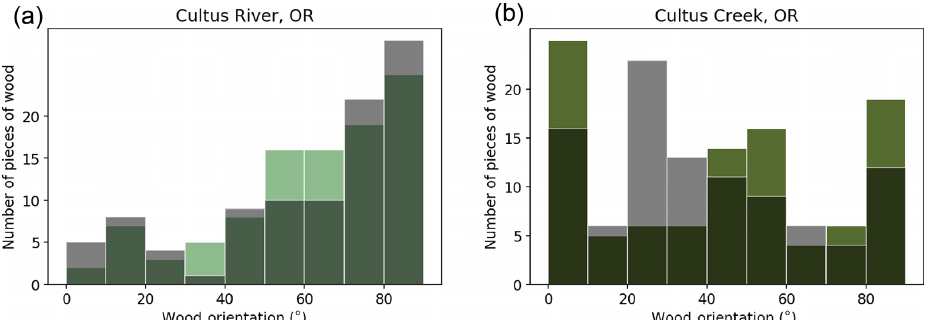
Figure 1. Orientation of wood was measured from an adjacent bank for approximately 100 pieces of wood using © Google Earth Pro (green). Hygelund (2002) measured orientation of wood in the field (transparent black). Data are shown together for (a) Cultus River and (b) Cultus Creek. The distributions align very well for Cultus River and have the same qualitative shape for Cultus Creek, although the center peak is displaced between the two sets of